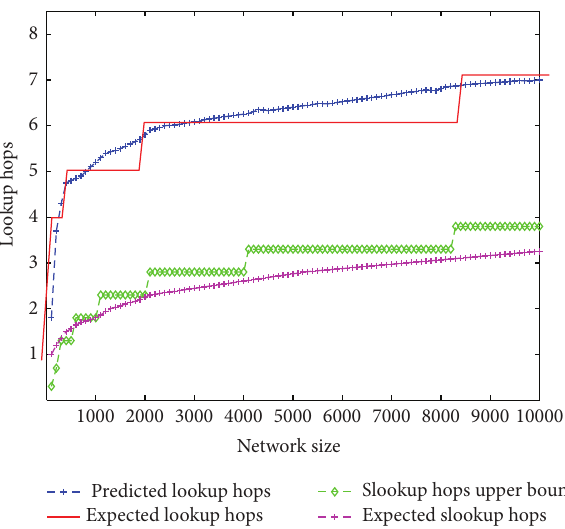
Figure 7: Lookup time for keys under Zipf distribution.